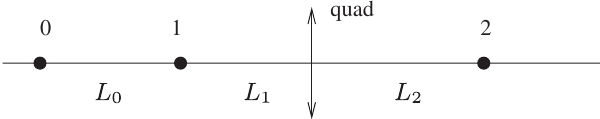
FIG. 1. Calibration of one quadrupole with three